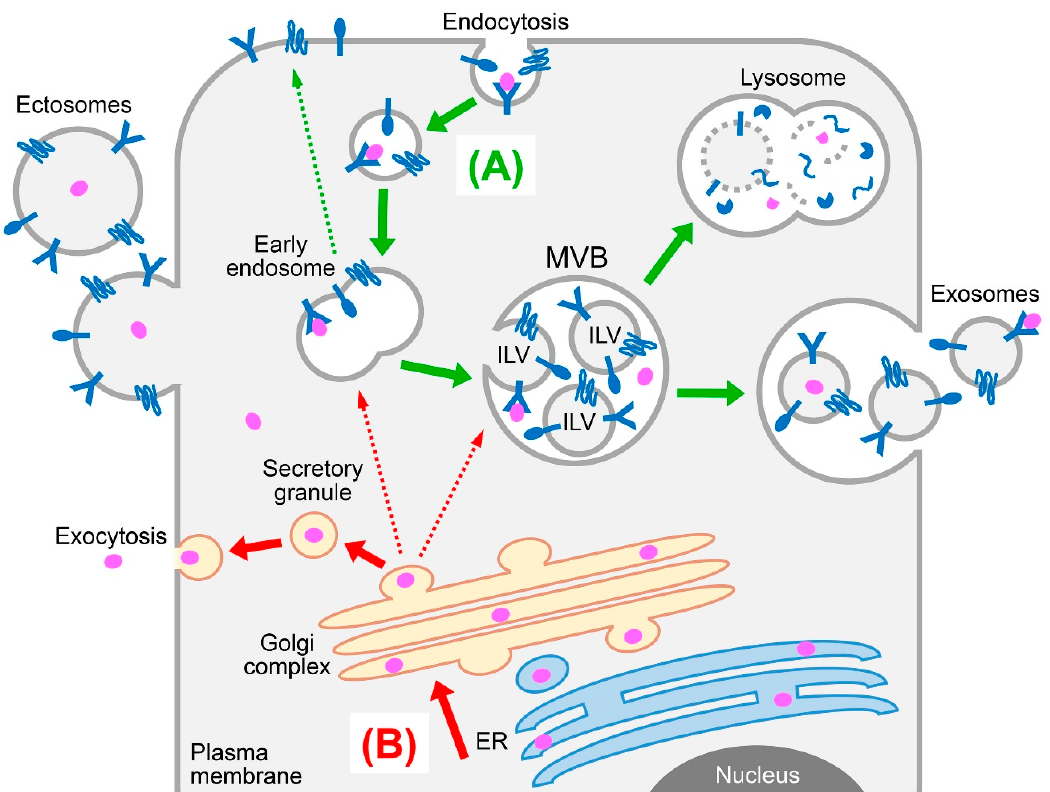
Figure 1. Schematic representation of protein sorting and secretory pathways. ( A ) Cell surface receptors and other integral membrane proteins (shown in dark blue) are internalized by endocytosis and routed to early endosomes (green arrow). From there, the proteins are recycled back to the plasma membrane, or are sorted into intraluminal vesicles (ILV) that form through inward budding of endosomes and give rise to multivesicular bodies (MVB). Fusion of MVBs with lysosomes results in degradation of ILVs and their cargo, whereas fusion of MVBs with the plasma membrane results in release of ILVs as exosomes. Unlike exosomes, ectosomes (also known as microvesicles or microparticles) form through outward budding of the plasma membrane. ( B ) Most receptor ligands (shown in pink) are trafficked to the endoplasmic reticulum (ER) and then to the Golgi complex (red arrow). From there, the proteins are routed to endosomes, or are packaged into secretory granules that then fuse with the plasma membrane, resulting in release of proteins into the extracellular milieu.